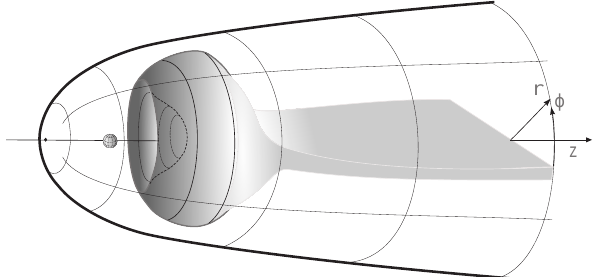
Fig. 2. Model of the medium, and the coordinate system. The plasma sheet is grey. The near-Earth part of the plasma sheet (NEPS) has asymmetry about the z axis. Magnetopause is a paraboloid with its focus in the Earth’s centre. Coordinates ( r,z,ϕ ) form a cylindrical coordinate